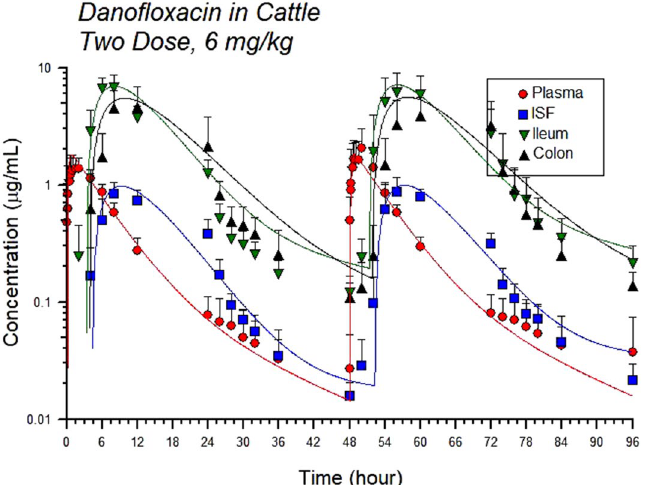
Figure 1. Total concentration of danofloxacin in plasma, interstitial fluid (ISF), ileum and colon ultrafiltrate dosed at 6 mg/kg, once every 48 h . Each point represents the mean and the error bars represent the standard deviation. The circle indicates plasma concentrations, the square indicates ISF concentrations, the upside down triangle indicates ileum ultrafiltrate concentrations and the right side up triangle indicates colon ultrafiltrate concentrations. The data is presented on a semi-logarithmic axis. The solid lines represent the predicted concentration based on the model fit. The actual values are the solid